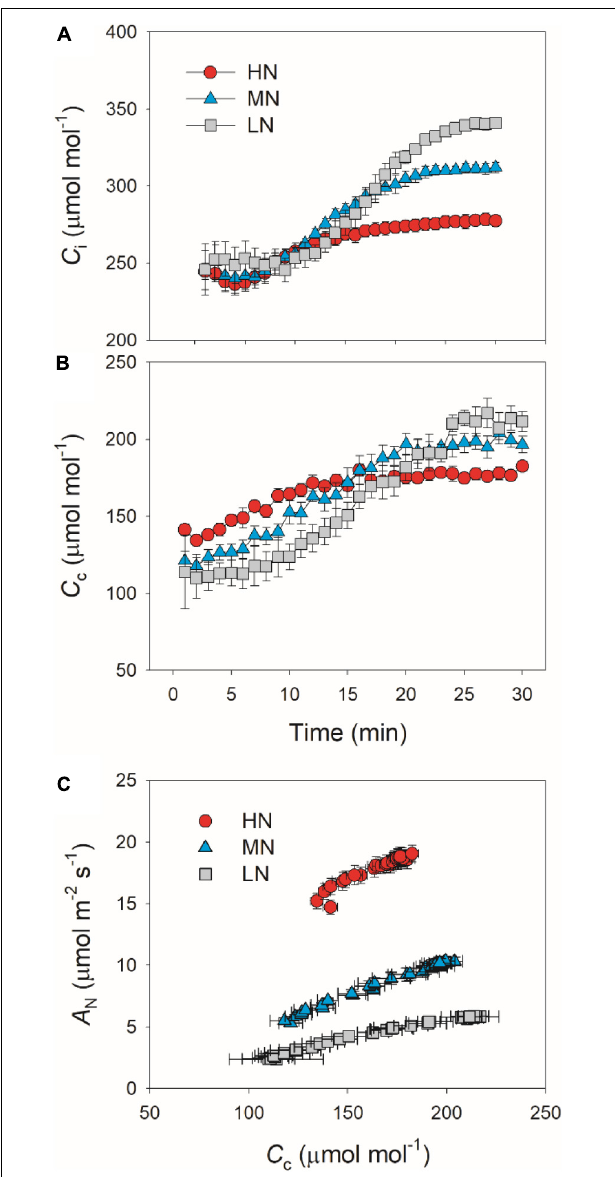
FIGURE 5 | Relationships between g s , g m and C c after transition from 50 to 1,500 µ mol photons m − 2 s − 1 in HN-plants (A) , MN-plants (B) , and LN-plants (C) . Values are means ± SE ( n = 5). HN, MN, and LN represent tomato plants grown under high, medium, and low N concentrations,